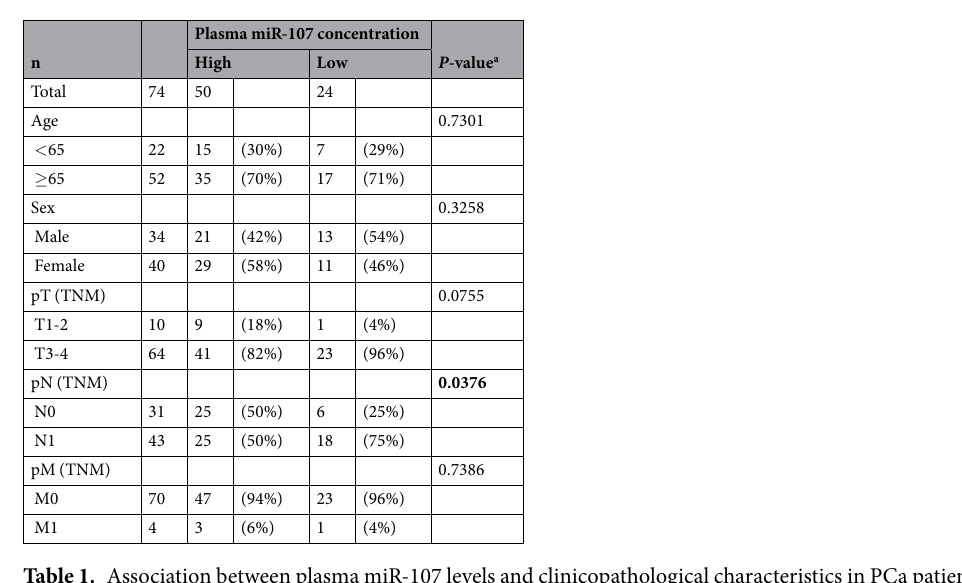
Table 1. Association between plasma miR-107 levels and clinicopathological characteristics in PCa patients with pancreatectomy. a Chi-square test. NOTE: significant values are in